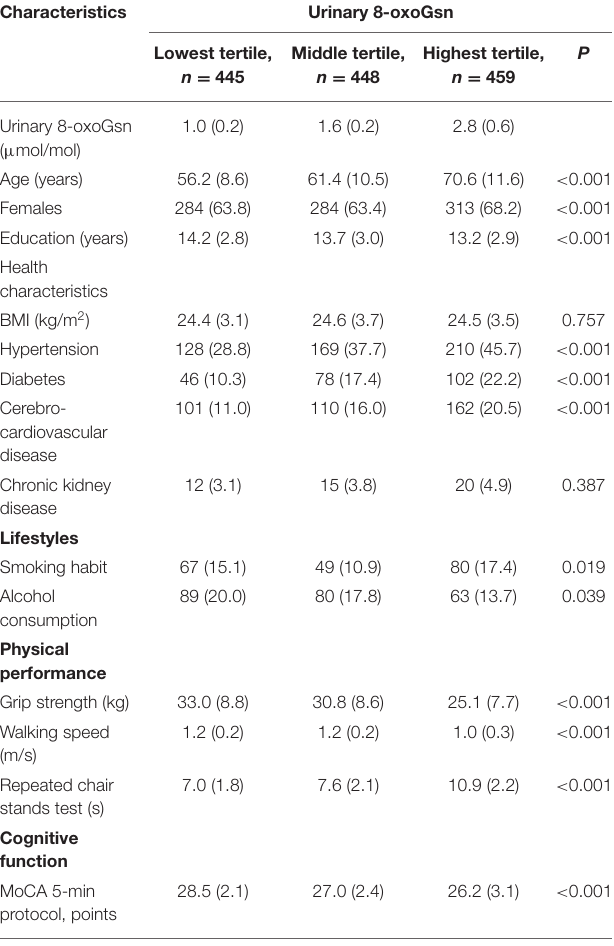
TABLE 2 | Sociodemographic characteristics and cognitive and physical function parameters of the participants, according to tertile of urinary 8-oxoGsn.